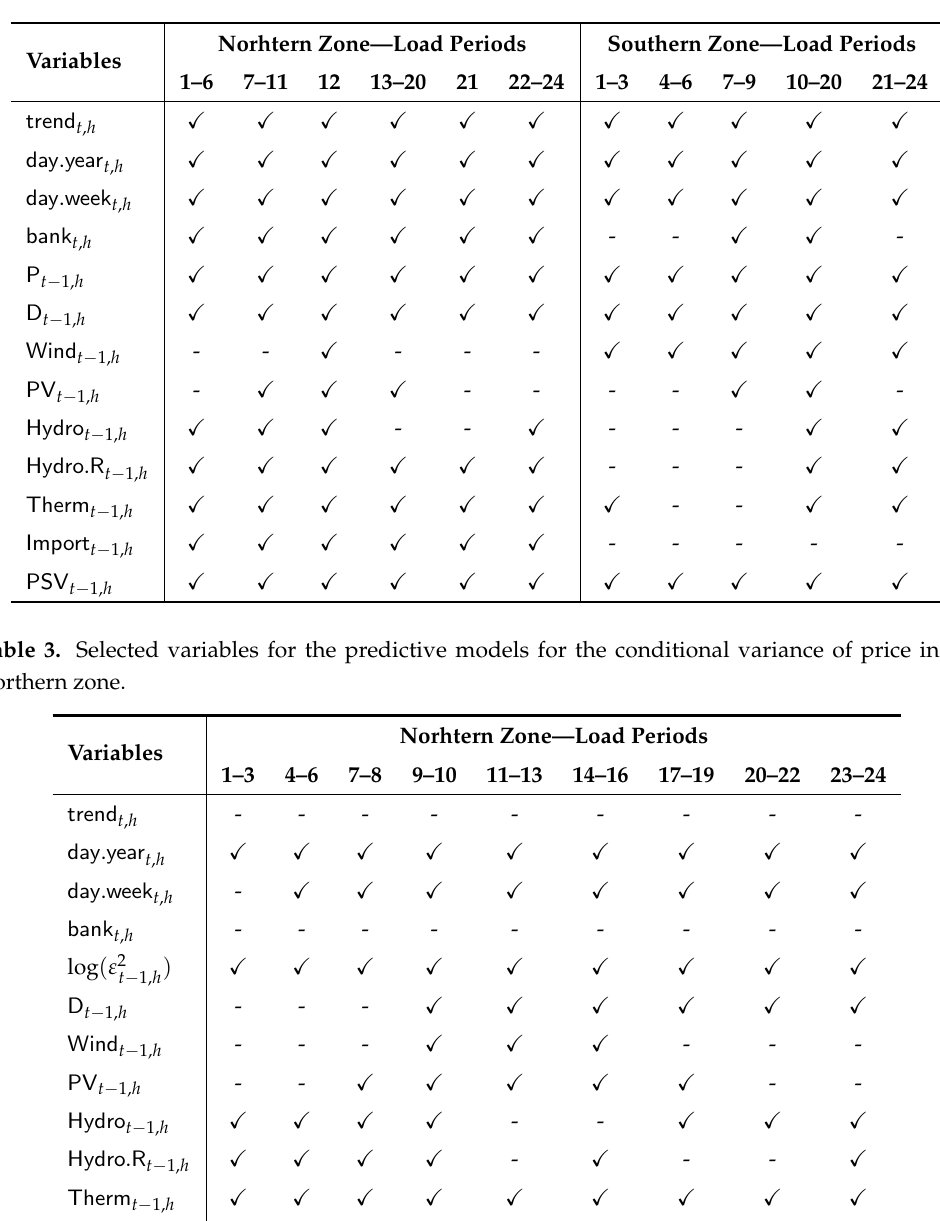
and southern zones.